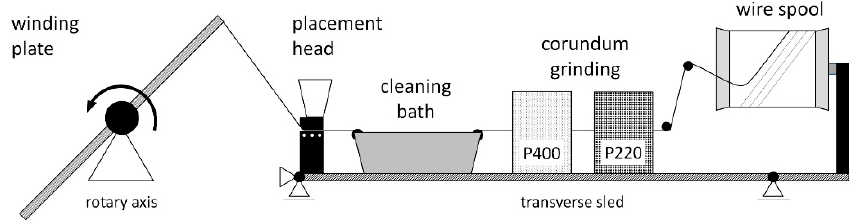
Figure 4. Fine wire-winding machine.